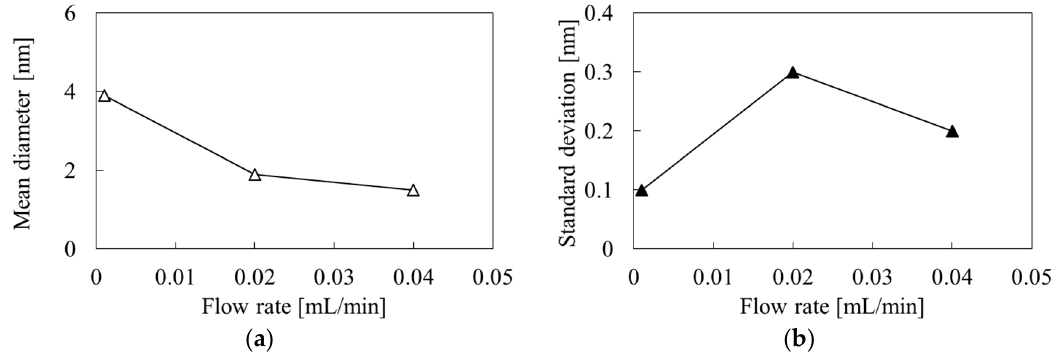
Figure 4. ( a ) Mean diameter and ( b ) standard deviation of CuNPs synthesized in the device calculated by number-size distribution of dynamic light scattering measurement as a function of the flow